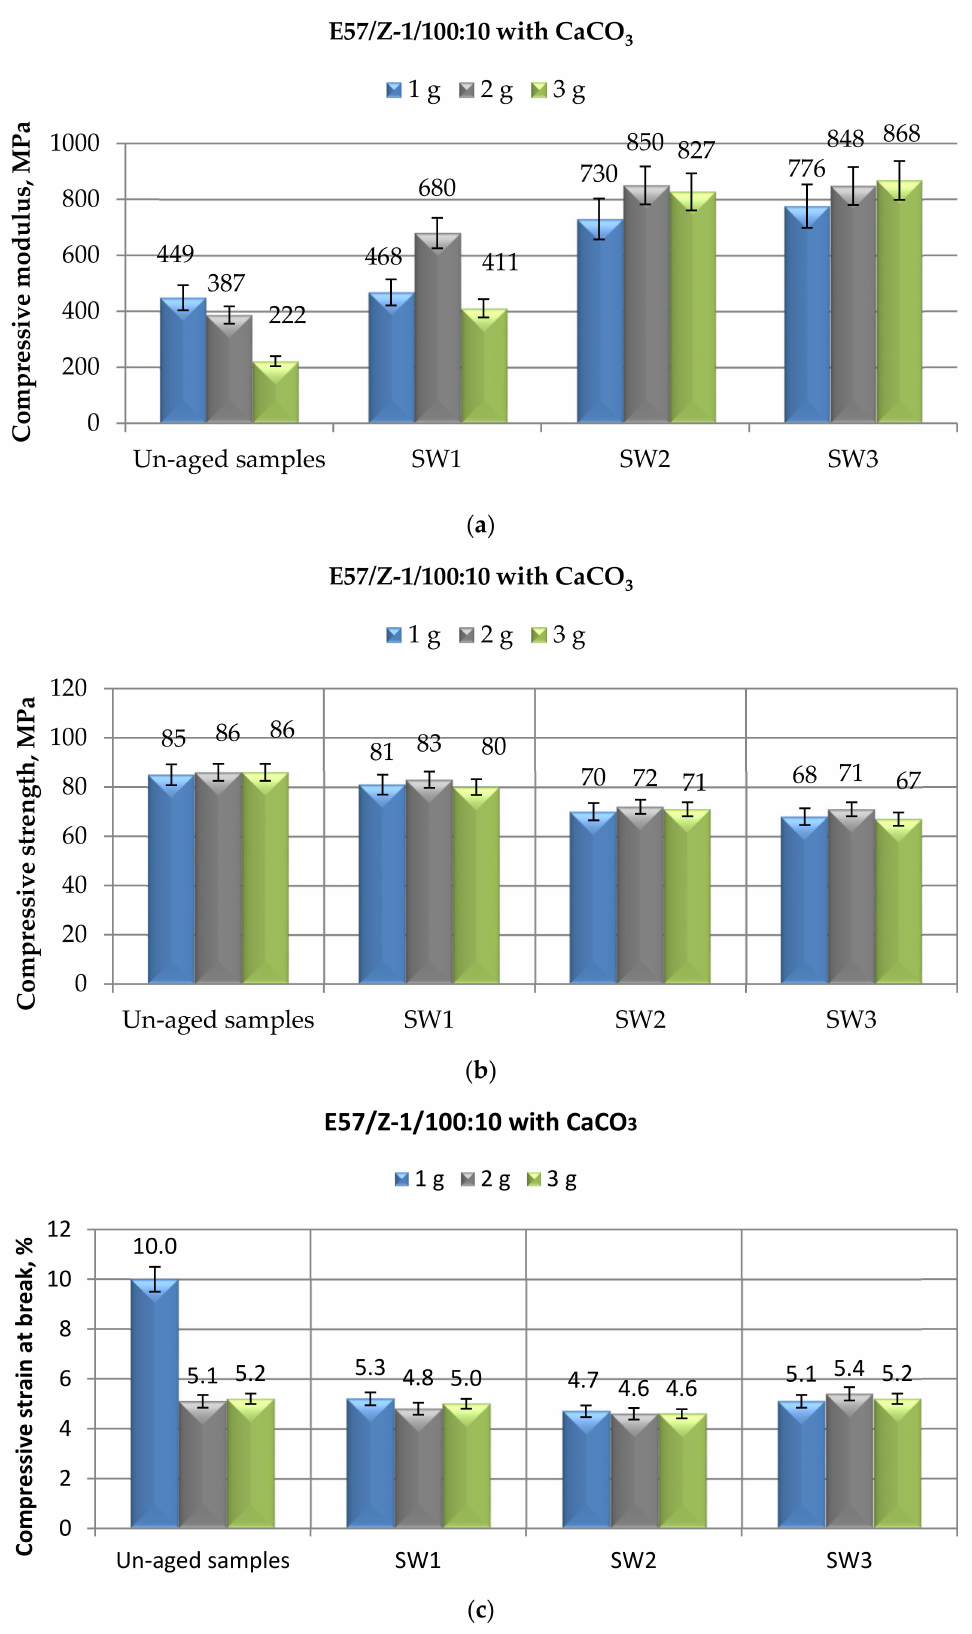
Figure 8. Results of mechanical tests performed in compression mode on CaCO 3 -filled E57/Z-1/100:10 specimens after different immersion times (i.e., 1, 6, and 10 months) in spring water, in terms of ( a ) Compressive modulus; ( b ) Compressive maximum strength; ( c ) Compressive strain at